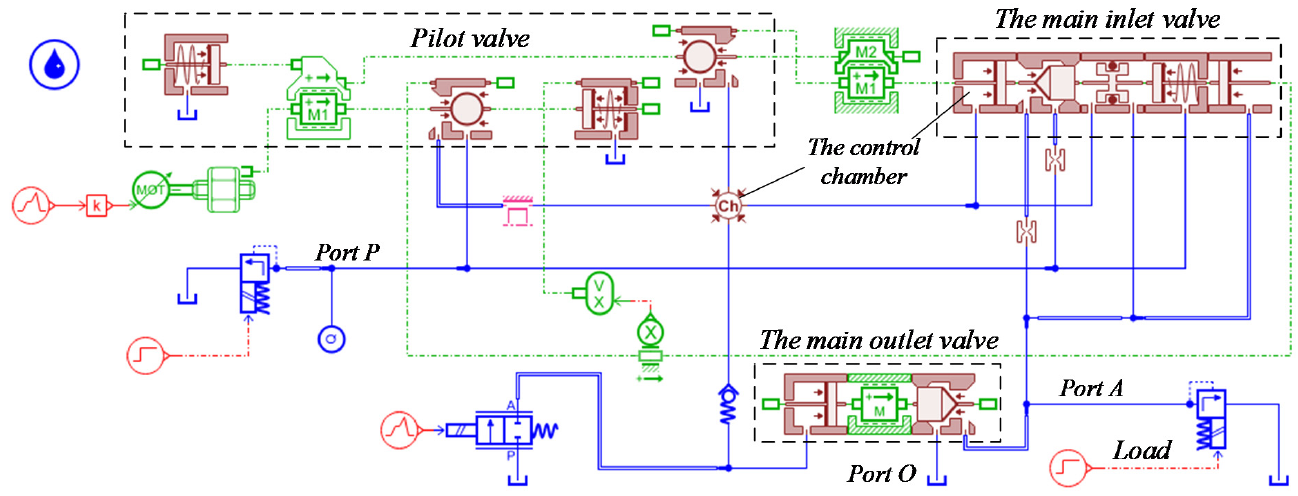
Figure 6. The simulation model of the proportional valve in AMESim.